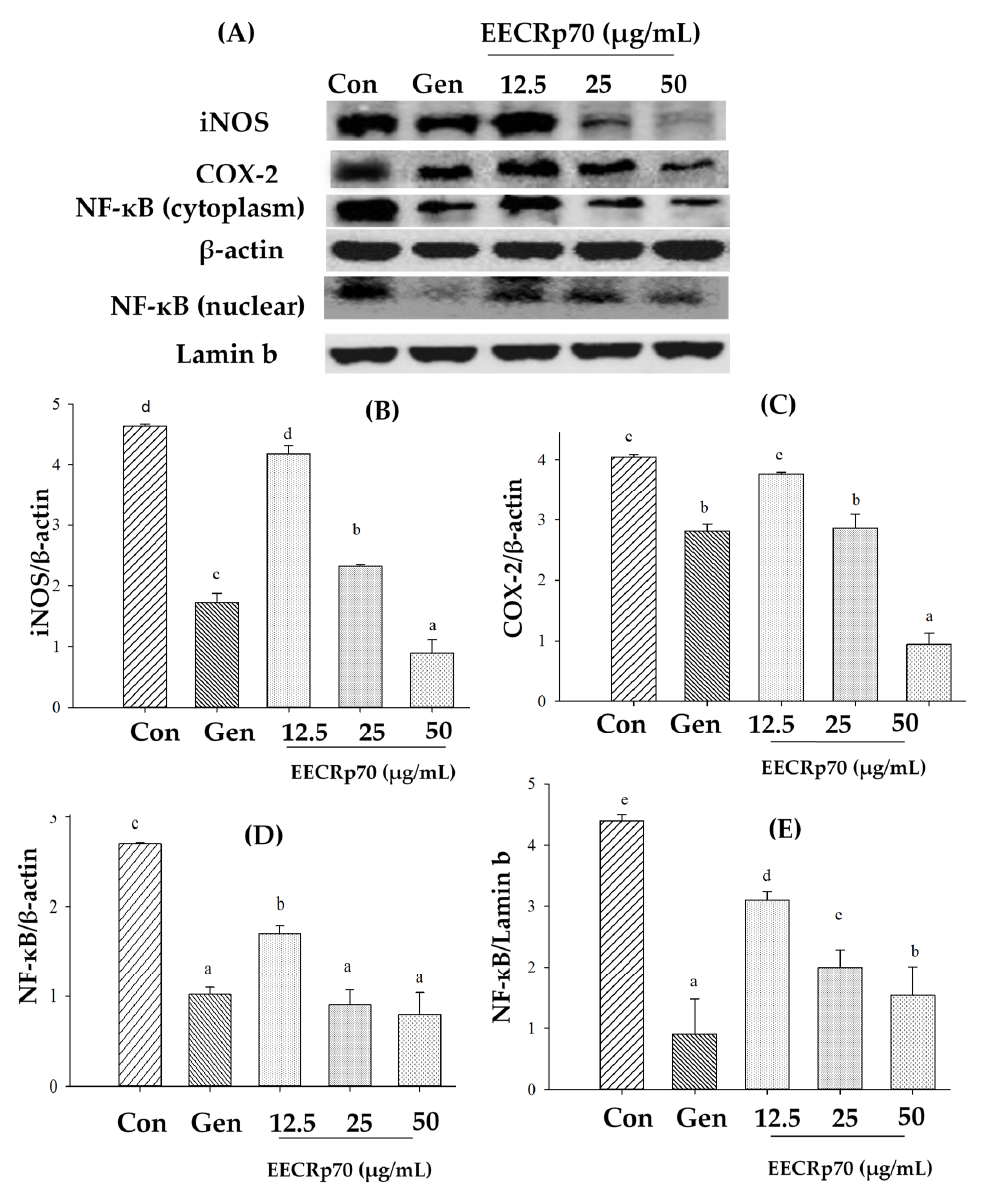
Figure 10. Effects of EECRp70 on expression level in SCC25 cells. Cells were treated with EECRp70 (12.5–50 µ g/mL) and genistein (25 µ M) for 24 h. ( A ) Protein expression of iNOS, COX-2, NF-kB (cytoplasm) and β -actin, or NF-kB (nuclear) and lamin b were detected in cytoplasm and nuclear by Western blotting. Quantitative values of ( B ) iNOS, ( C ) COX-2, ( D ) NF-kB (cytoplasm), and ( E ) NF-kB (nuclear) were analyzed using ImageJ software. Values (mean ± SD) that do not share a common letter are significantly different ( p <